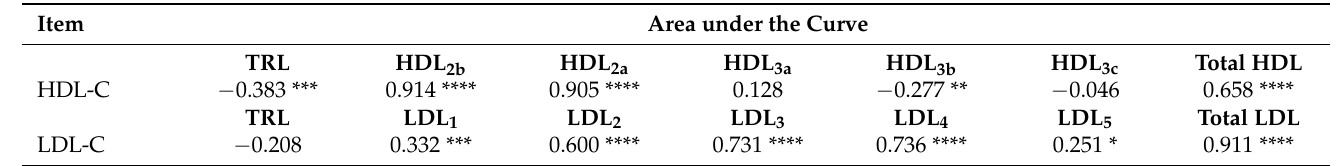
Table 6. Pearson correlations among plasma HDL-C and LDL concentrations and area under the curve for HDL and LDL subfractions 1,2